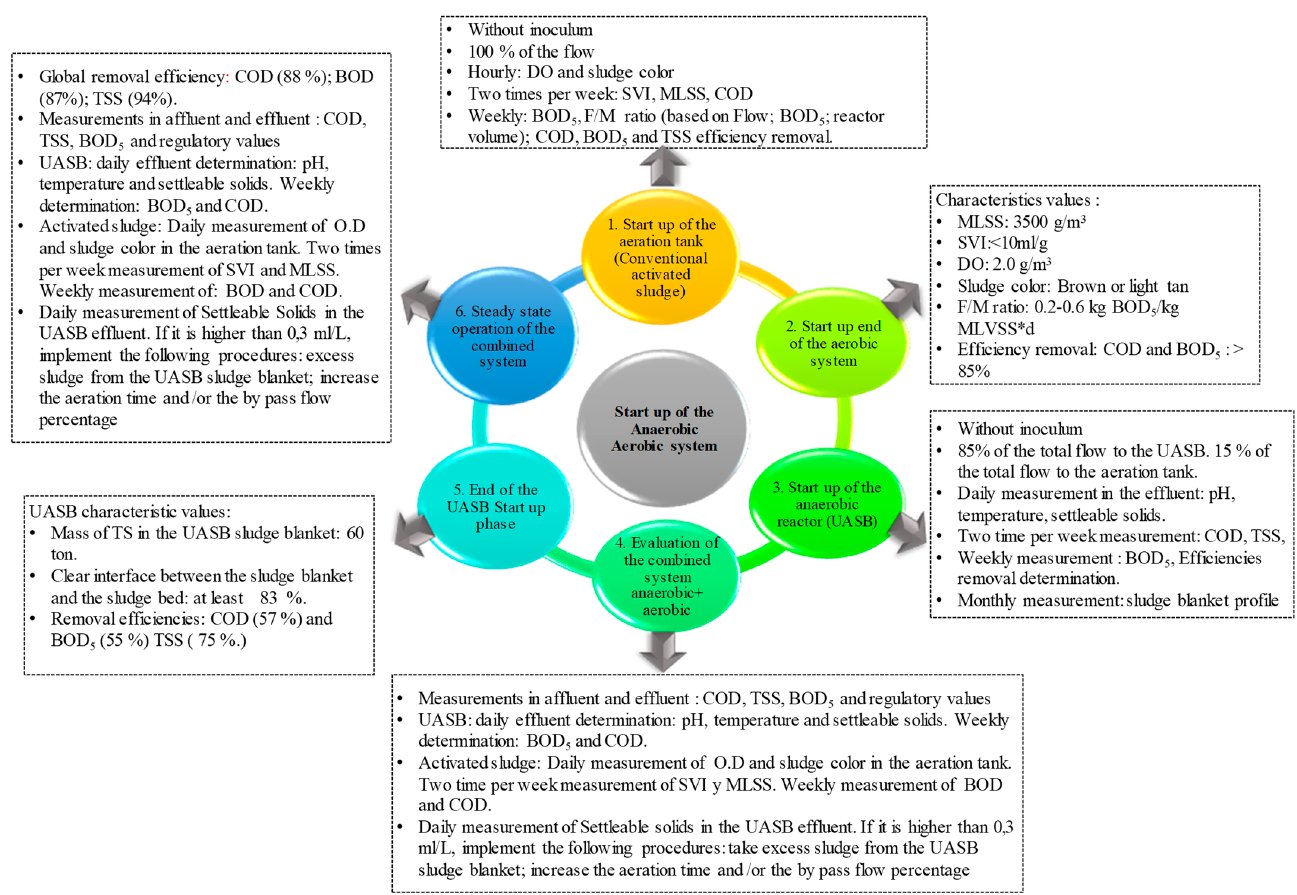
Figure 9. Important aspects during the start-up and operation of combined sewage treatment sys- tems (anaerobic–aerobic). systems